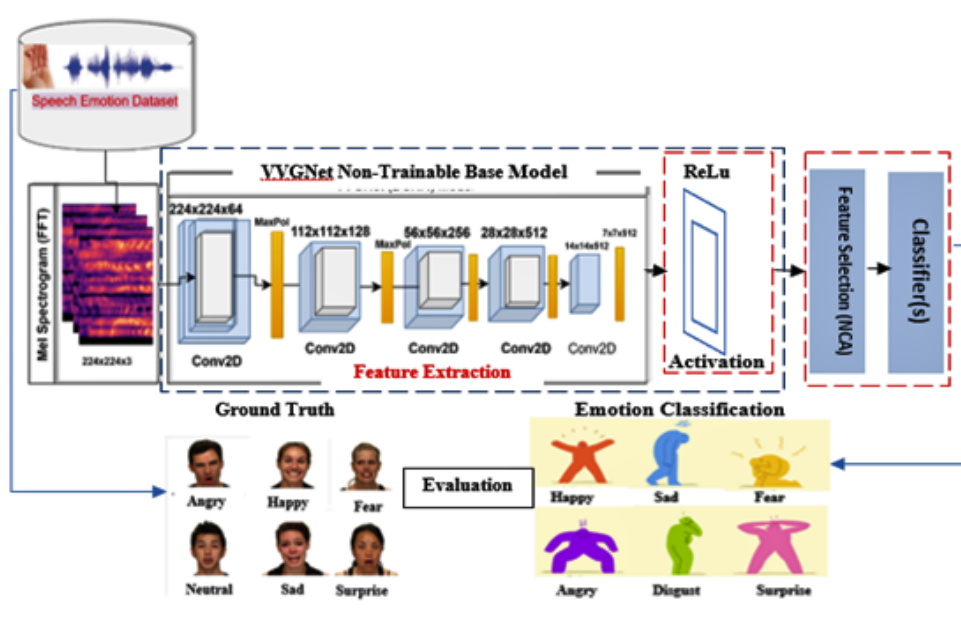
Figure 2. Structure of the Proposed